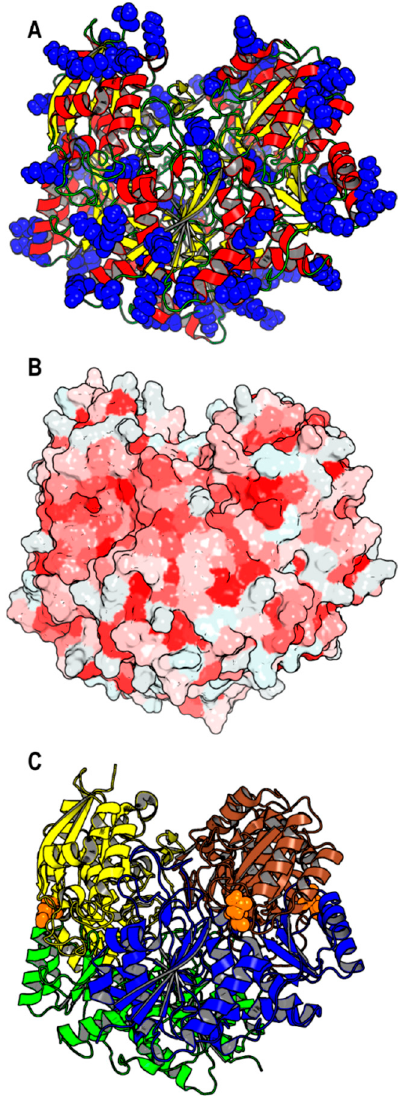
Figure 11. Analysis of the 3D structure of asparaginase from Erwinia chrysantemi in tetrameric form (PDB 1O7J). ( A ) The superficial Lys of the enzyme are highlighted in blue spheres on the secondary structure of the enzyme. ( B ) The colors of the enzyme surface indicate hydrophilic areas (white) and hydrophobic regions (red). ( C ) The tetrameric structure with each monomer colored differently while the glycosylation sites are highlighted in orange sphere mode.